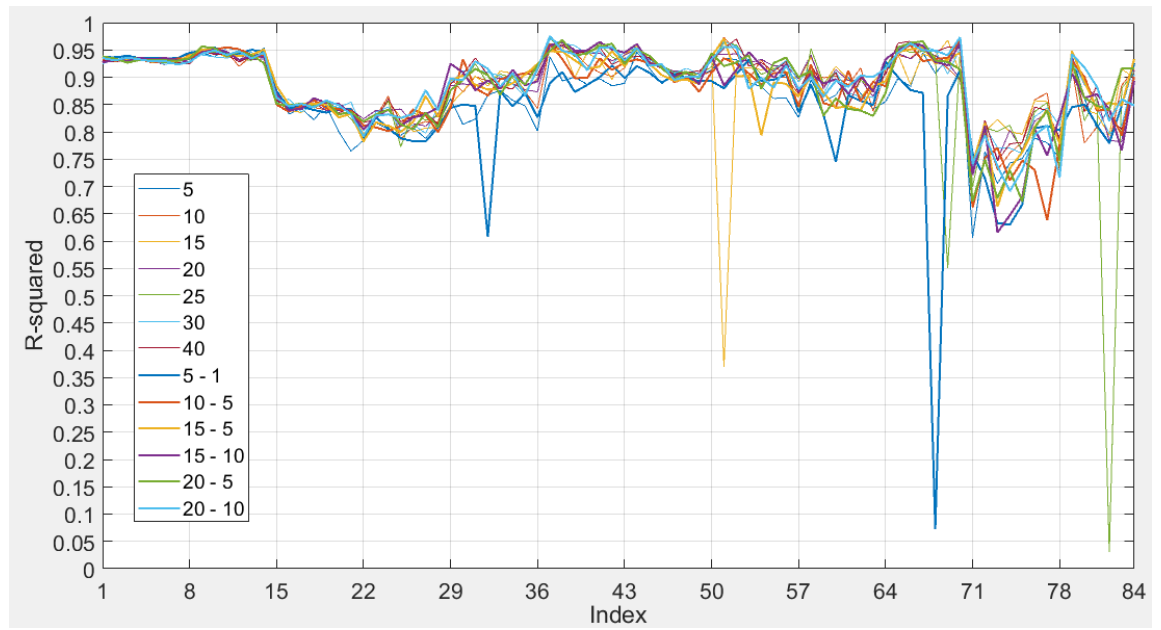
Figure 11. R 2 values for neural network regression models for P 0 .